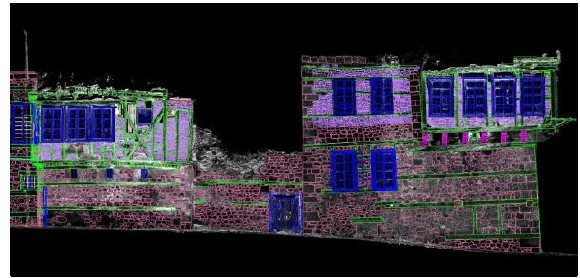
Figure 7. 3D CAD Drawings by ZMap